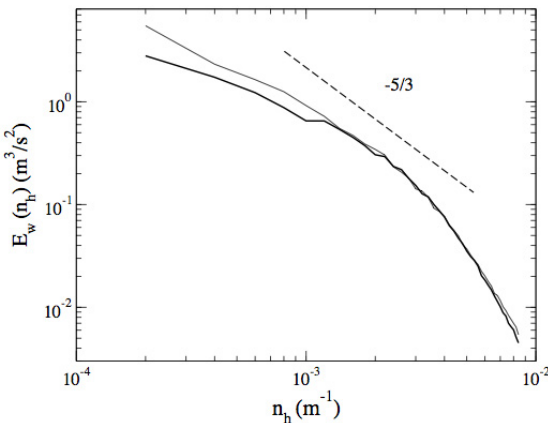
Fig. 9. Vertical velocity one-dimensional spectra for wavenumbers n h in the horizontal plane, measured from the LES runs with (thick line) and without (thin line) subsidence. Spectra are measured in both cases in the mixed layer, at the fixed height z/z i = 0 . 7. The dashed line gives the Kolmogorov slope for the inertial range of scale.